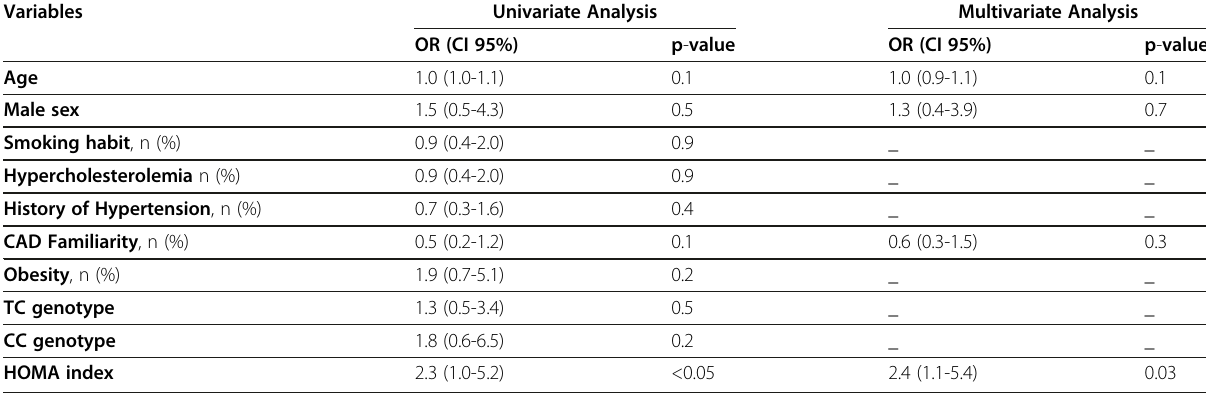
Table 3 Predictors of severe LV dysfunction with HF at univariate and multivariate analysis by logistic regression